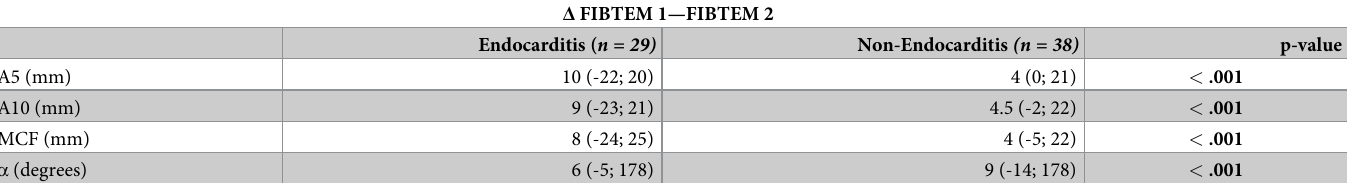
Table 4. Differences between preoperative and post-declamping FIBTEM in patients with and without infective